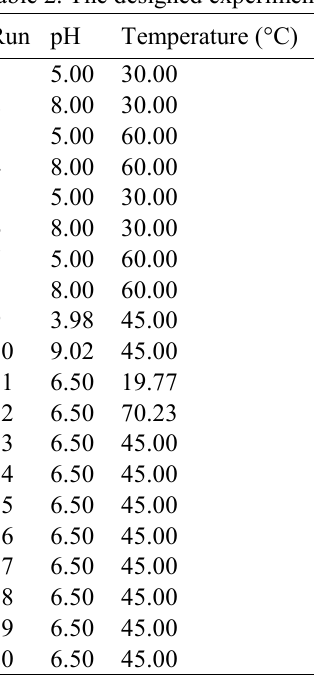
Table 2. The designed experiments by CCD for the removal process